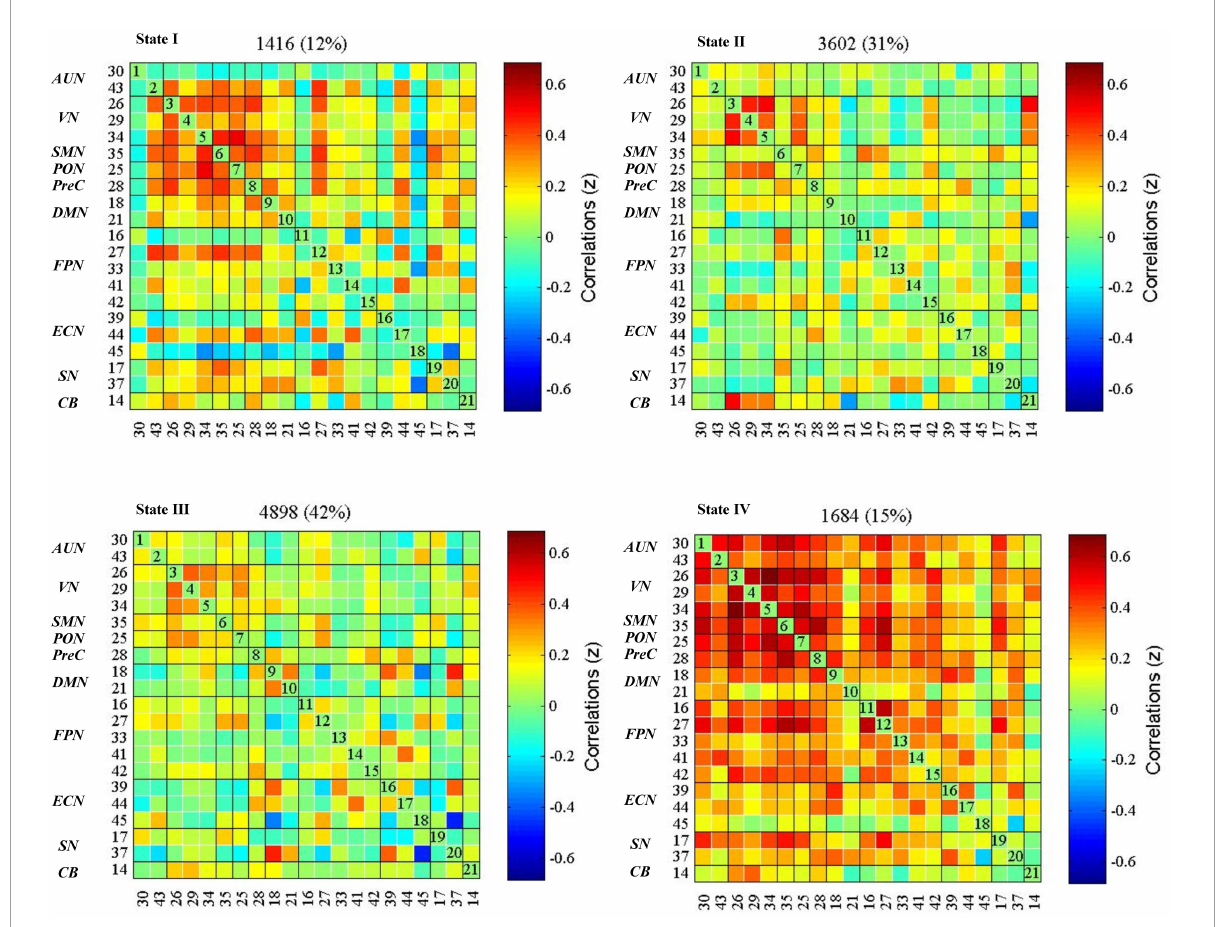
FIGURE3 dFNC states in the whole sample ( k = 4). The centroid of each functional network connectivity state with the total number of occurrences of each state and percentage of the total number of occurrences. The color bar represents the value of the correlations: Red color represents positive correlations and blue color represents negative correlations. AUN, the auditory network; VN, the visual network; SMN, the sensorimotor network; PON, the occipital network; PreC, the precuneus network; DMN, the default mode networks; FPN, the frontoparietal network; ECN, the executive control network; SN, the salience network; CB, the cerebellar network.